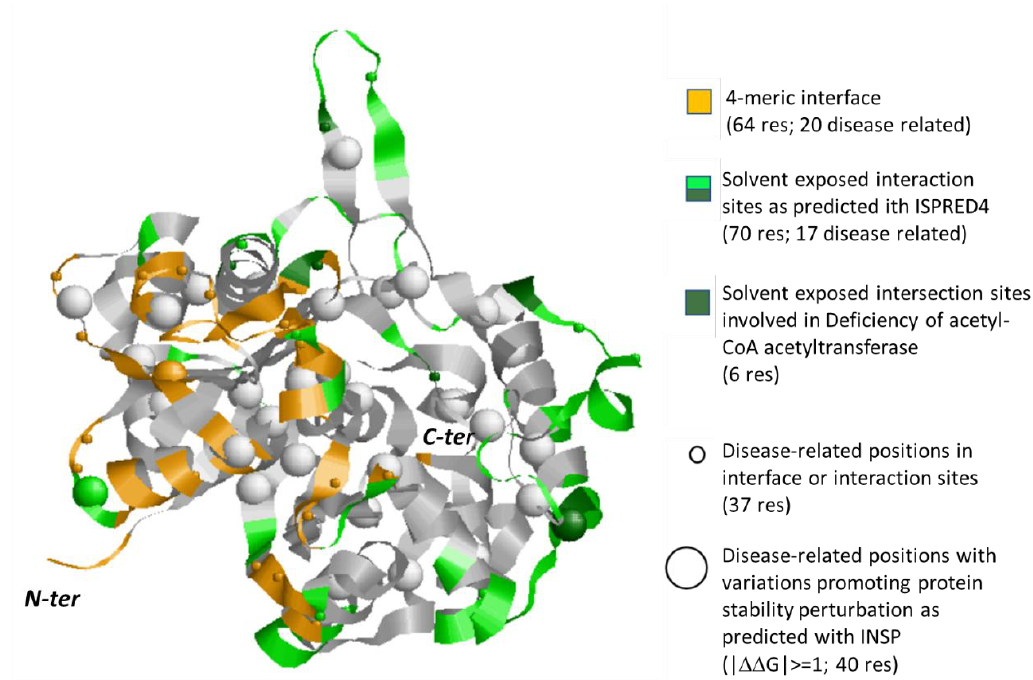
Figure 6. Monomeric subunit of human ACAT1 protein (PDB code: 2IBY.A). Interaction surface in the tetramer as derived from the crystallographic coordinates is in orange. Interaction sites out the tetrameric interface, as predicted with ISPRED4 are in green. Positions in these regions carrying disease related variations (Table S3) are highlighted with small spheres. Big spheres highlight positions in the protein carrying disease related variations (Table S3, for details) and promoting a large variance of folding free energy, as predicted with INPS [26]. Grey color: the background protein backbone.